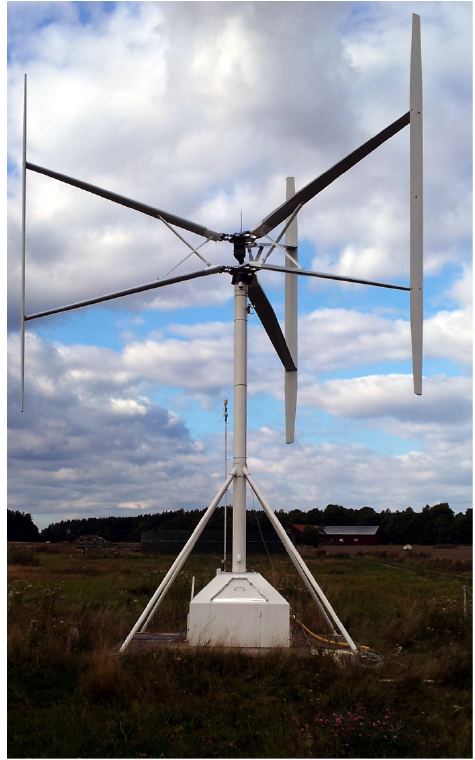
Figure 3. The 12 kW turbine, designed and built by the Division of Electricity at Uppsala University. The turbine is equipped with load cells used for the force measurements